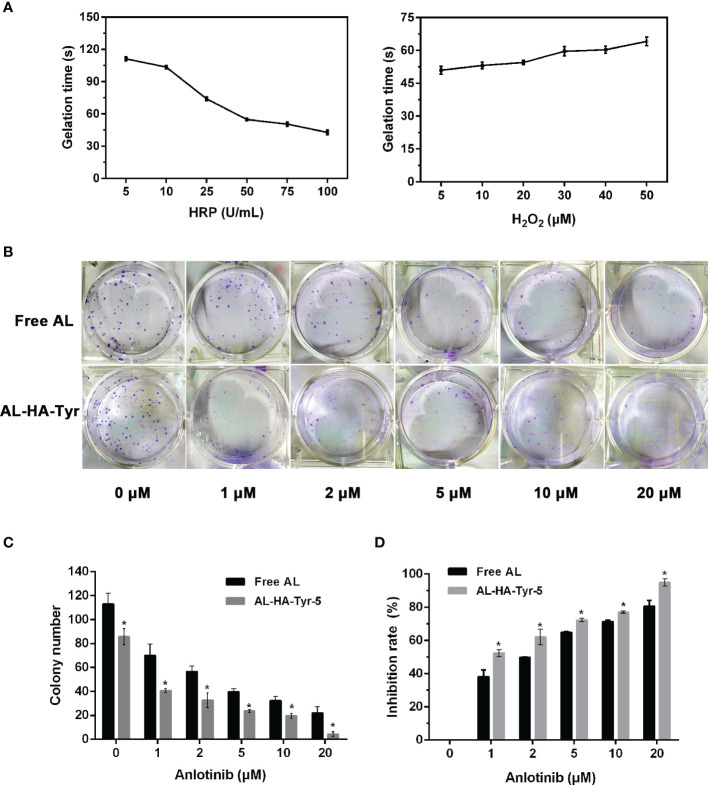
Factors affecting gel formation and effects of anlotinib hydrogel (AL-HA-Tyr) on colony formation. (A) Gelation points of hyaluronic acid-tyramine (HA-Tyr) conjugates at different concentrations of H2O2 and horseradish peroxidase (n = 6). Data are shown as means ± SD. (B) Representative images of colony formation assays using human umbilical endothelial cells (HUVECs) incubated with various concentrations of anlotinib (AL) or anlotinib hydrogels (AL-HA-Tyr) + lysozyme-5. (C) Quantitation of colony formation of HUVEC in vitro. (D) Inhibition rate of colony formation in AL and AL-HA-Tyr-5. Data are shown as means ± SD. (n = 3). *P < 0.05, (Free AL vs. AL-HA-Tyr-5).